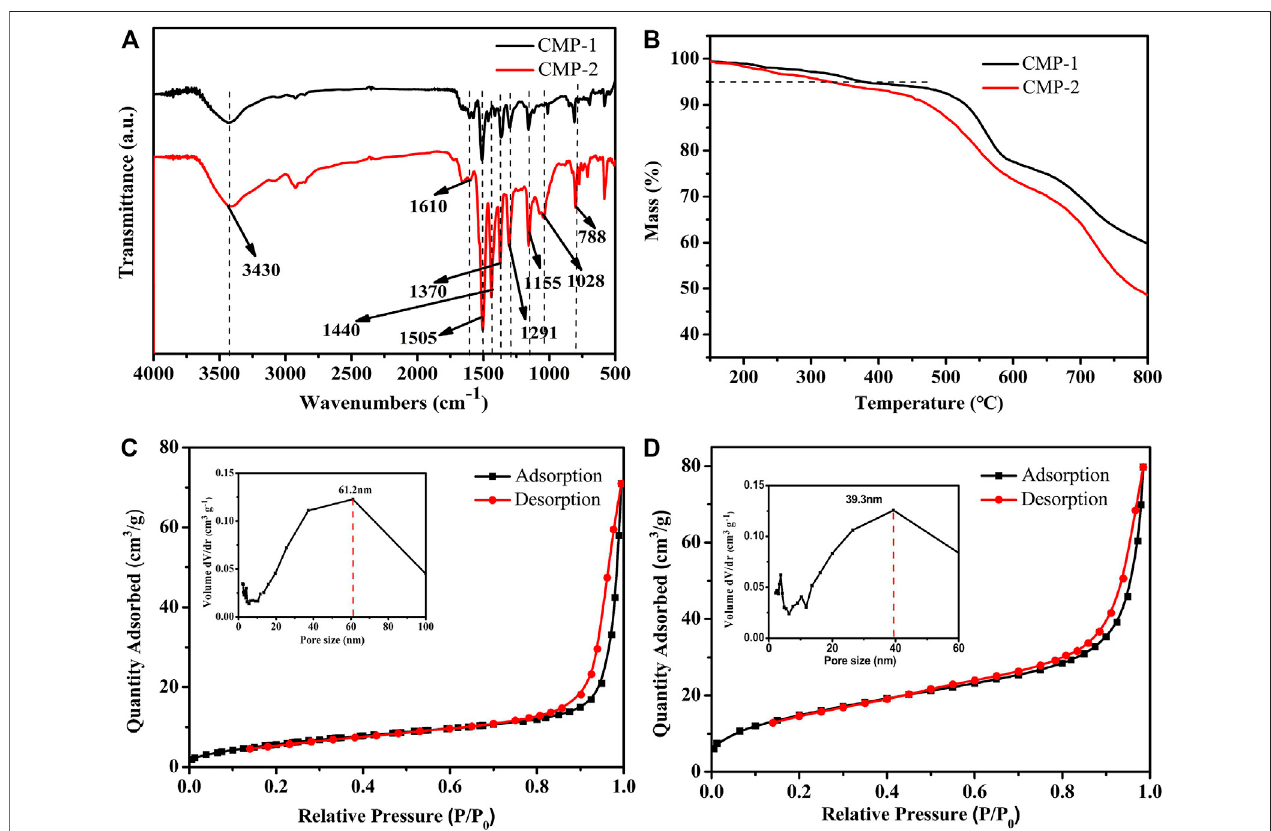
FIGURE 2 | (A) FT-IR spectra of CMPs. (B) TGA curves of CMPs. Nitrogen adsorption – desorption isotherms at 77 K and pore size distributions (insets) of (C) CMP-1 and (D)